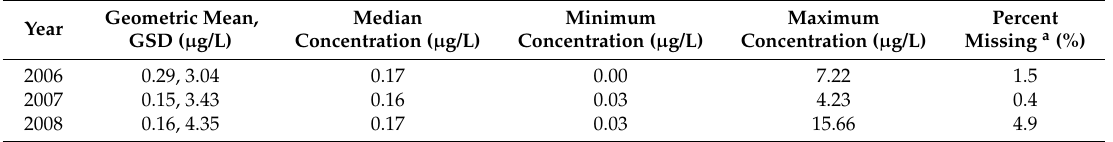
Table 1. Summary of monthly mean atrazine concentrations reported in finished drinking water by Atrazine Monitoring Program (AMP) community water systems ( n = 22) in Ohio,